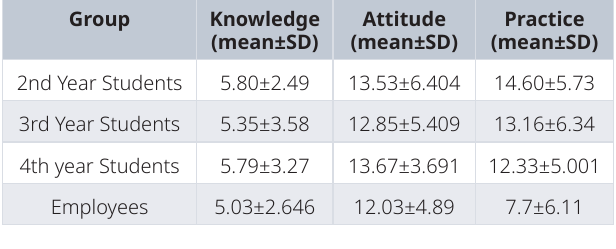
Table 6. Average scores (mean±S.D) of students and employees towards knowledge, attitude and practice.